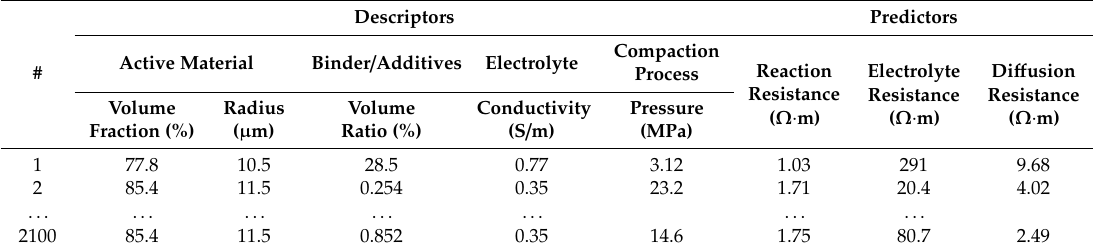
Table 3. The dataset for learning and testing, including the predictors and